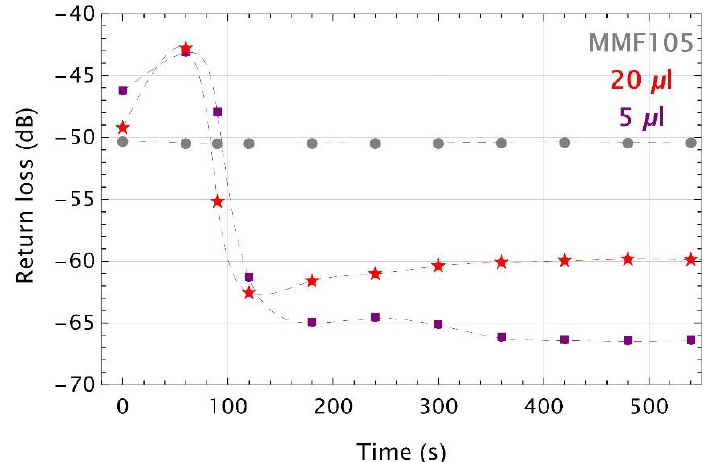
Figure 7. Time responses of MMF 105 with UV microtips with the presence of TMP in the glass vial of the volumes of: 5 µL (purple), 20 µL (red). Points joined with the gray dashed line are data of MMF105 without microtip tested for a TMP volume of 2 µL. Colored markers are experimental points, while the dashed lines are their cubic polynomial interpolations.